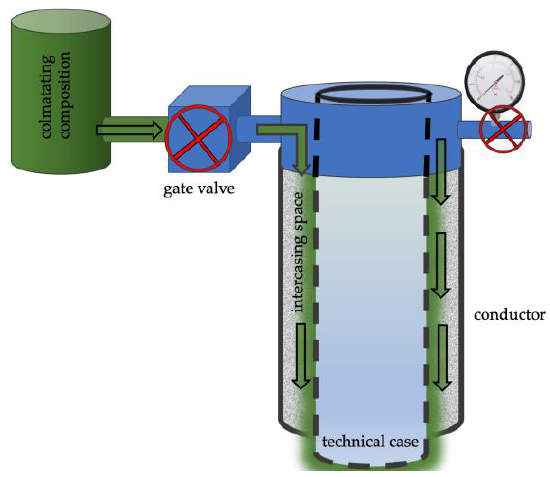
Figure 5. The method of eliminating leakage in the intercasing space.